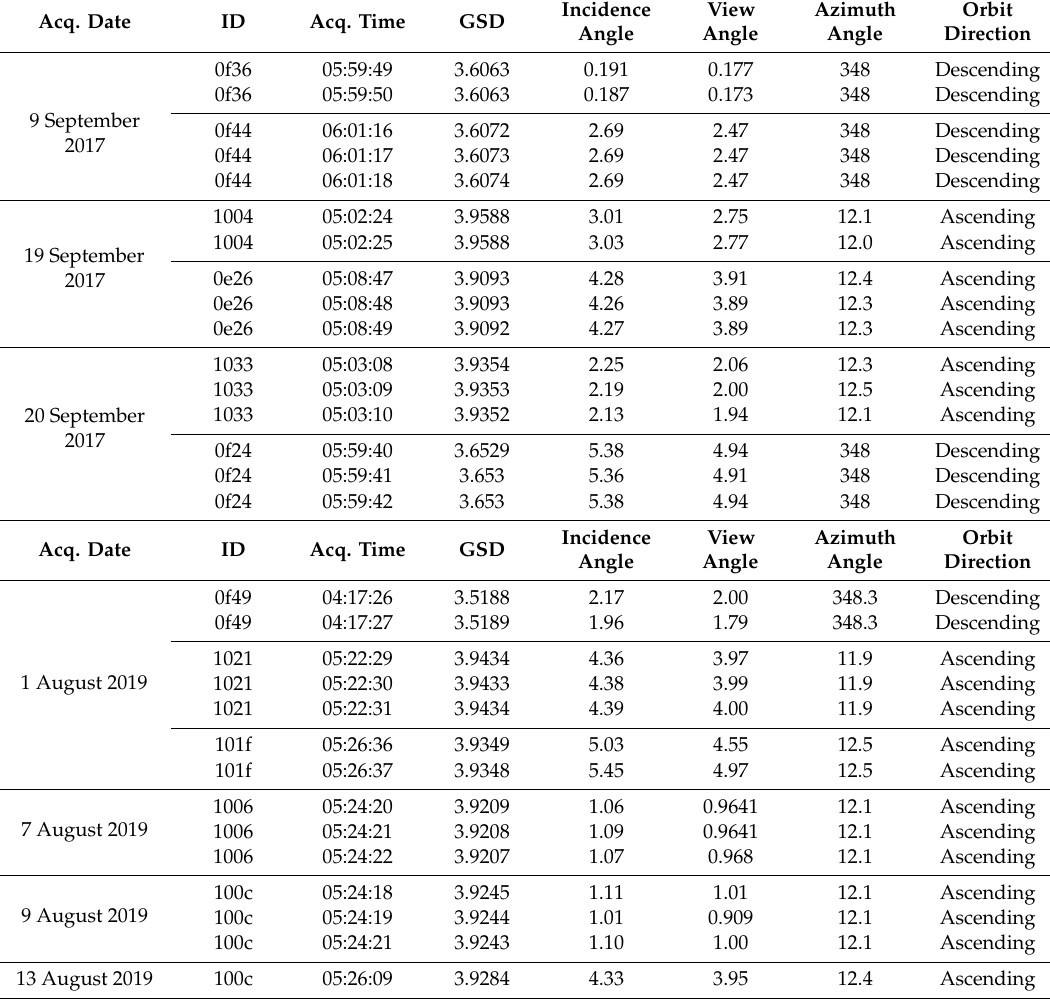
Table A2. Acquisition parameters for the PlanetScope imagery over Shisper glacier study area.